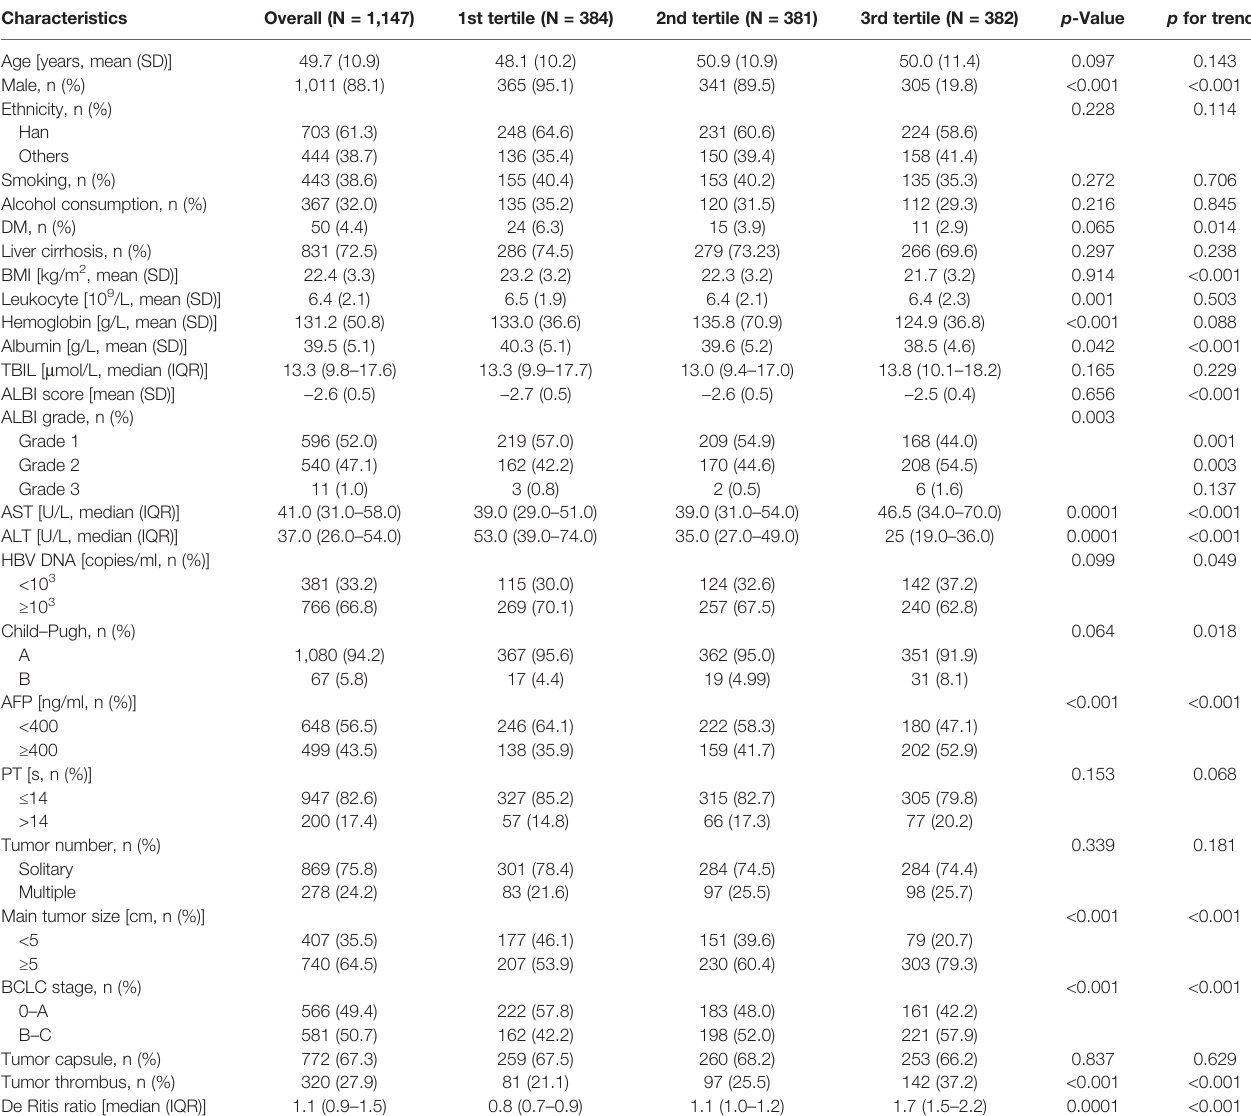
TABLE 1 | Baseline characteristics of the study patients according to tertiles of De Ritis ratio.